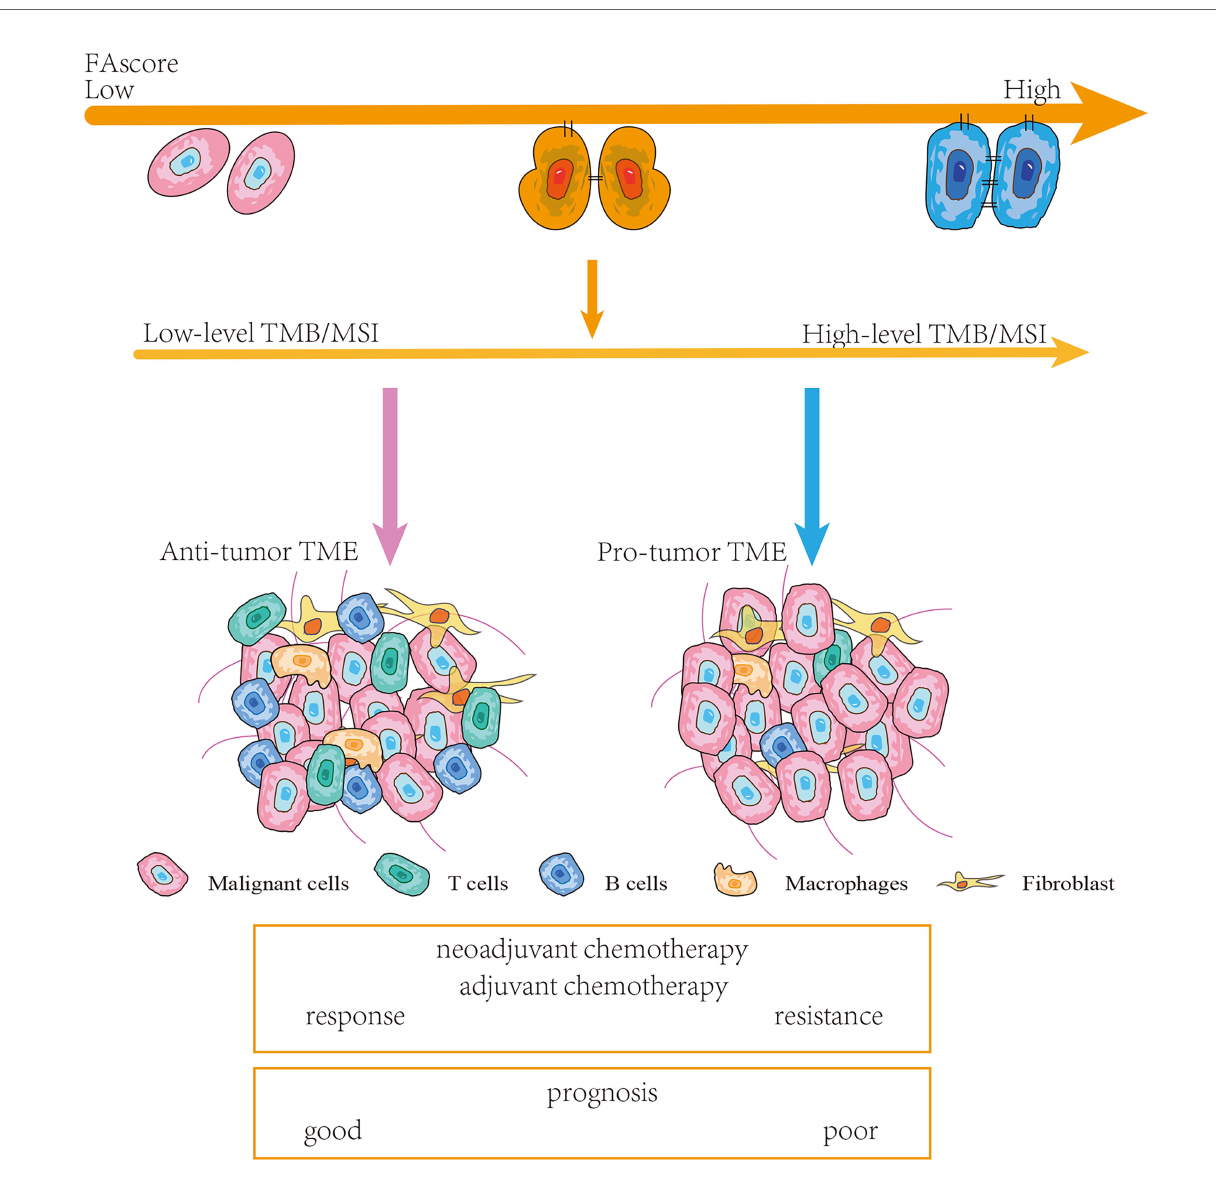
FIGURE 7 | Schematic diagram. Patients with high FAscores were frequently accompanied by high levels of tumor mutation burden (TMB)/microsatellite instability (MSI) and pro-tumor tumor microenvironments (TMEs). Thereby, such patients were more likely to respond poor to chemotherapy and had a shorter survival